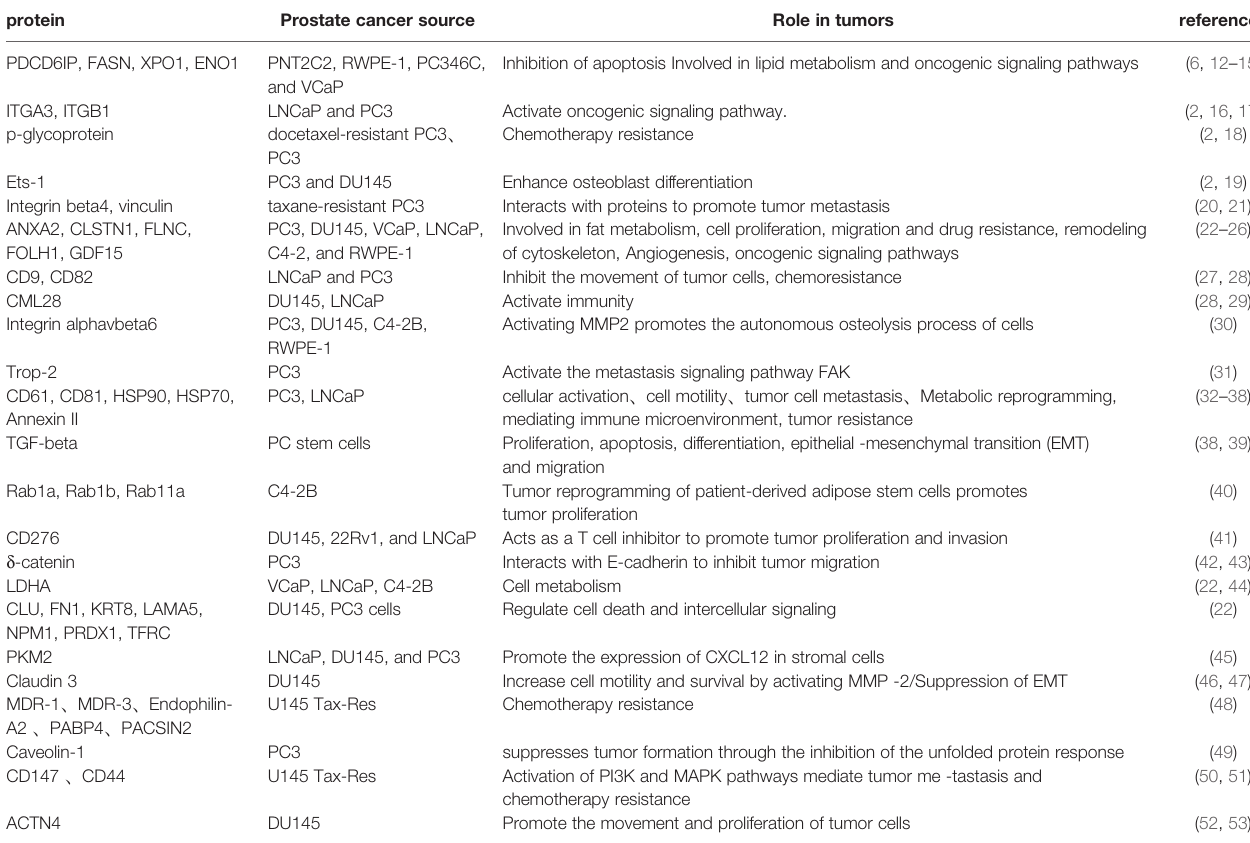
TABLE 1 | Exosomal protein derived from prostate cancer cell line. protein Prostate cancer